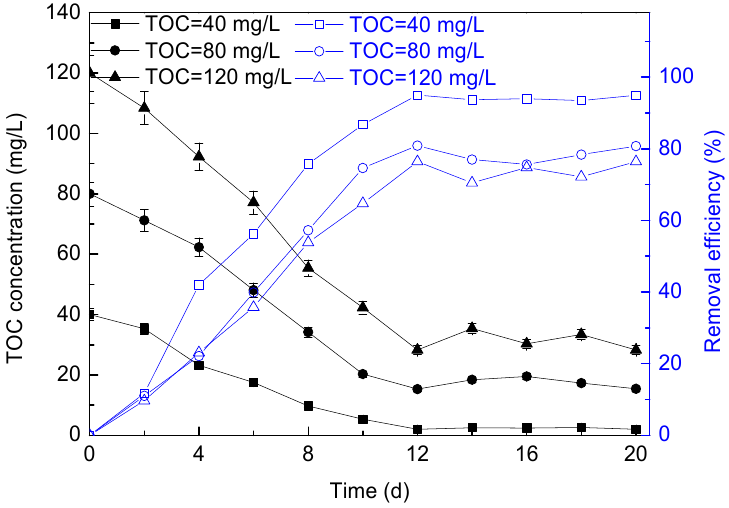
Figure 6. Changes in effluent TOC concentration and TOC removal efficiency under different TOC concentrations.